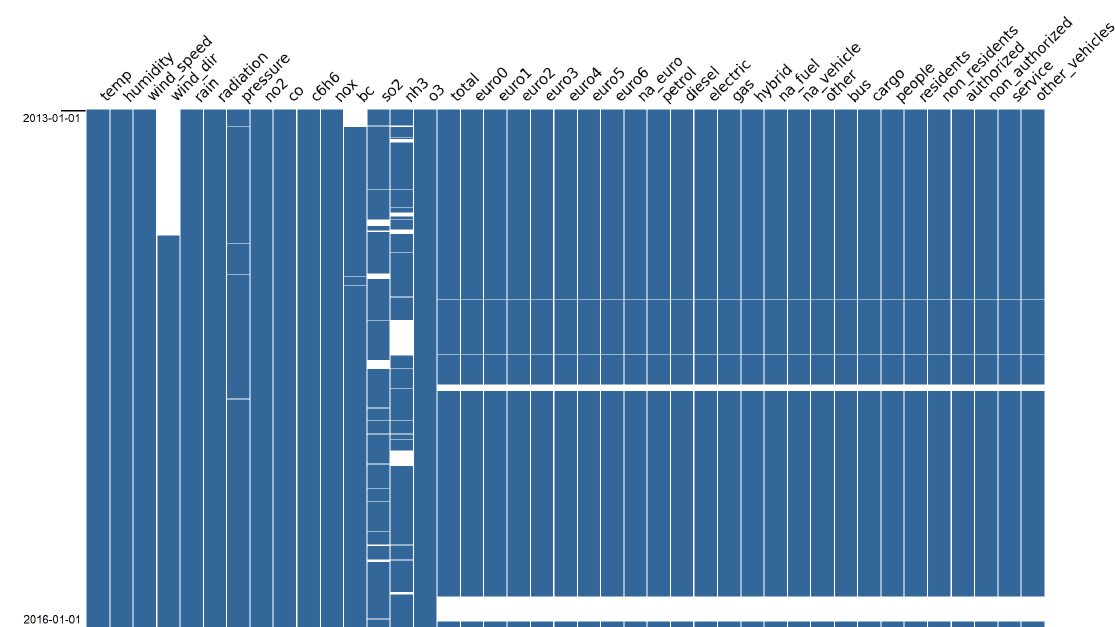
Figure 2. Missing values in the aggregated hourly set over the three-year span, highlighted by the white